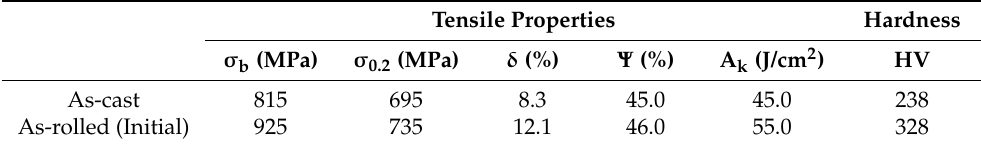
Table 1. Tensile properties and hardness of as-cast and as-rolled X6CrNiMoVNb11-2 steel.